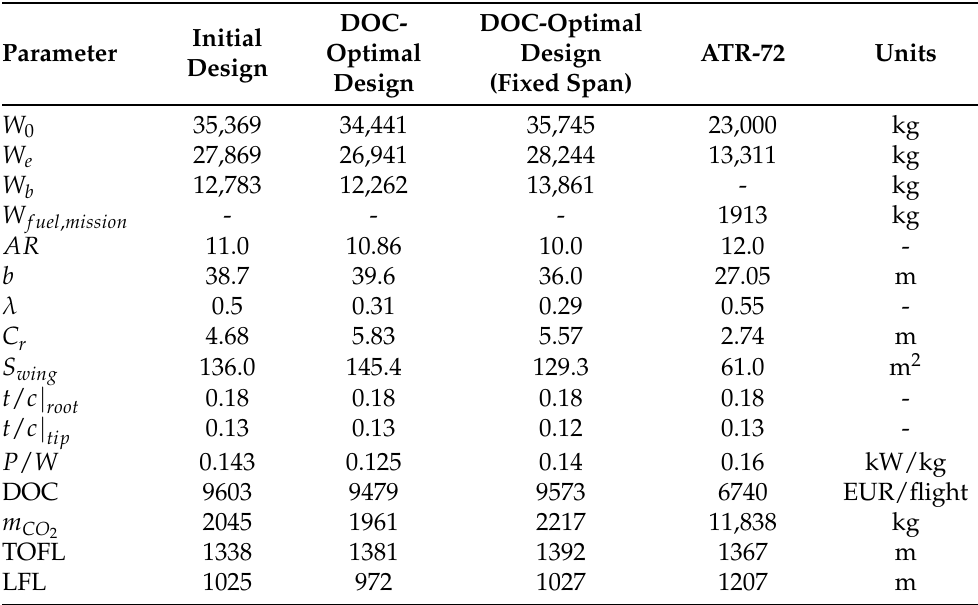
Table 7. Comparison between optimized concepts with and without the wing span